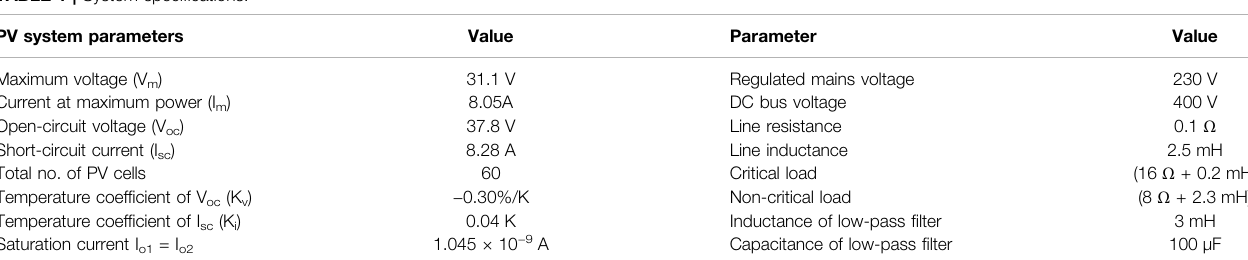
TABLE 1 | System speci fi